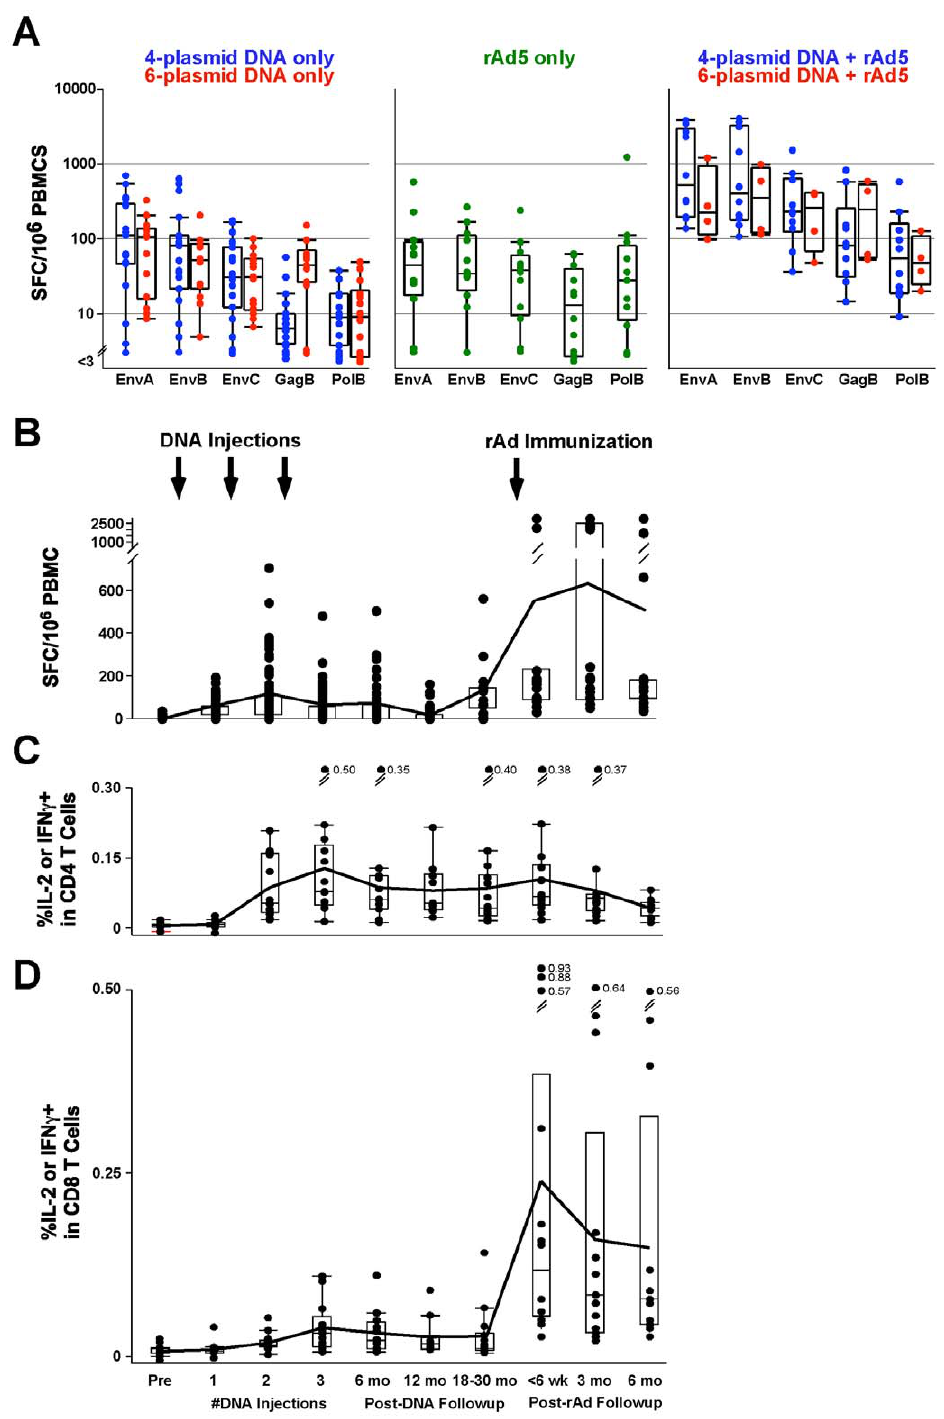
Figure 1. T cell responses to DNA are boosted by rAd immunization. (A) IFN- c ELISpot responses in subjects 4 weeks after third dose of DNA or after a single dose of rAd5 vector only compared to peak response at 4–6 weeks following rAd5 vector boosting. The scale indicates spot-forming cells per million peripheral blood mononuclear cells. Individual subject responses are shown for recipients of 4-plasmid (VRC 004) or 6-plasmid (VRC 007) vaccines (left panel), the rAd5 vector (VRC 006) vaccine (center panel), and the combined DNA/rAd5 prime-boost (right panel). Results for peptide pool stimulation are shown for each peptide pool representing a single gene product in the vaccine shown on the x-axis. Boxplots represent the median and IQR. Longitudinal T cell responses to EnvA peptides were measured by IFN- c ELISpot (B), CD4 + (C) and CD8 + (D) ICS and data are shown for all 14 subjects. The line graph shows the mean response at each time point. Some clinical time points were aggregated and are shown here as the mean value of the measurements for the grouped time points: The data following DNA injections # 2 and # 3 are the means of results from 2 and 4 weeks after the immunization time point; 6 month data post-DNA are the means of results from 16, 24, and 30 weeks after DNA injection # 3; and the , 6 week post-rAd5 time point data are means of results from 2, 4, and 6 weeks after rAd5 vector immunization.